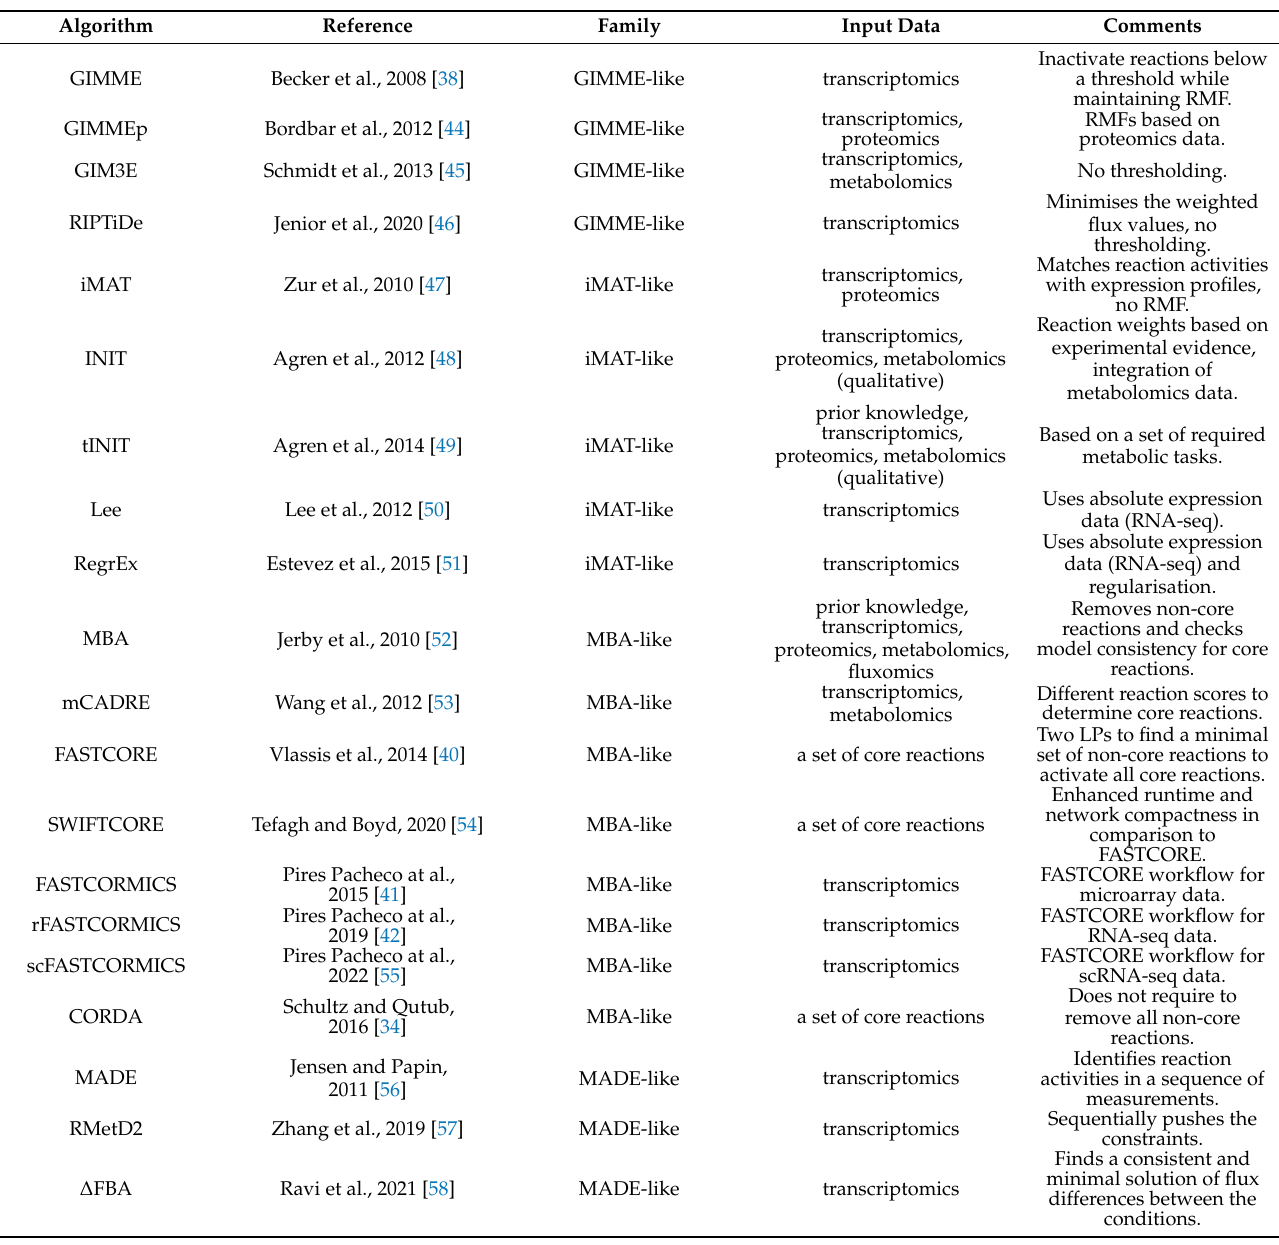
Table 2. An overview of algorithms for automated reconstruction of context-specific models.